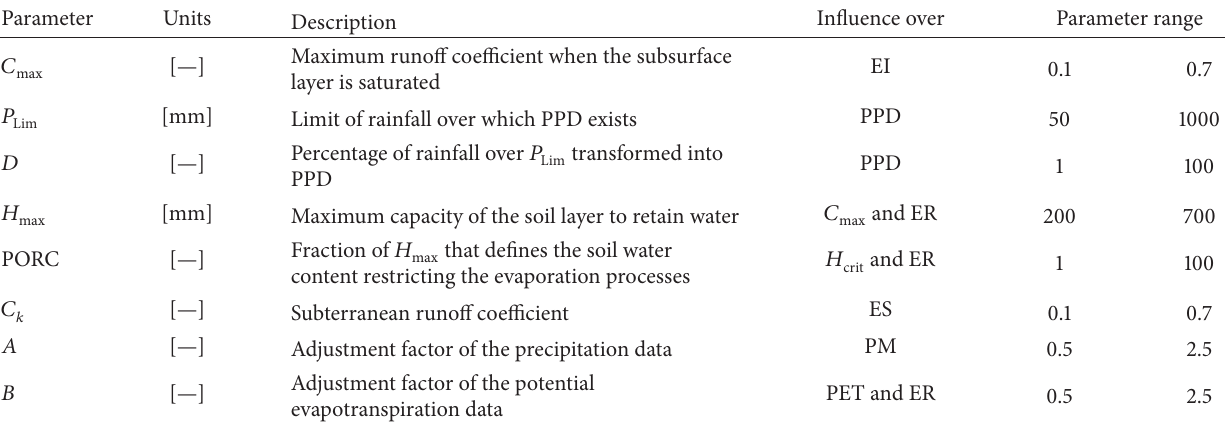
Table 1: Description of the model parameters and adjustment factors range for the rainfall-runoff module.